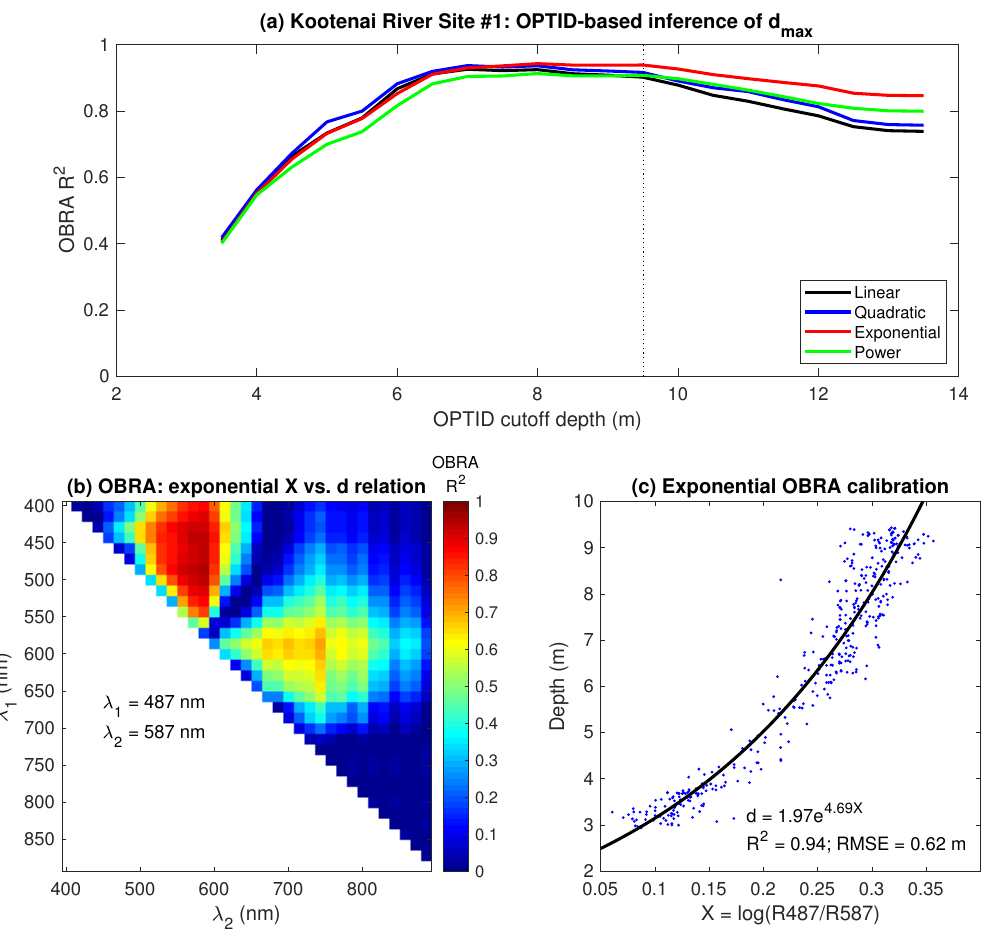
Figure 5. ( a ) summary of generalized OBRA of Progressively Truncated Input Depths (OPTID) with the inferred d max indicated by the vertical dashed line at 9.5 m; ( b ) Optimal Band Ratio Analysis (OBRA) matrix for the exponential model corresponding to the value of d max inferred via OPTID; ( c ) calibration scatter plot for the exponential X versus d relation.